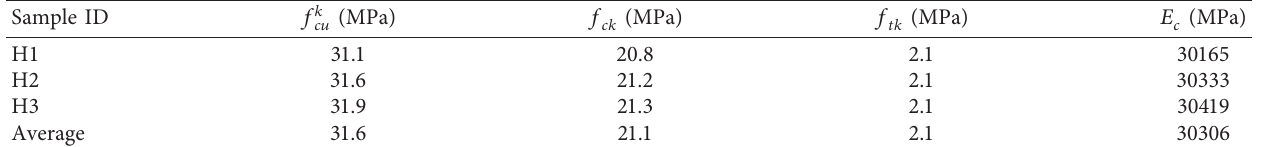
Table 1: Concrete material properties.